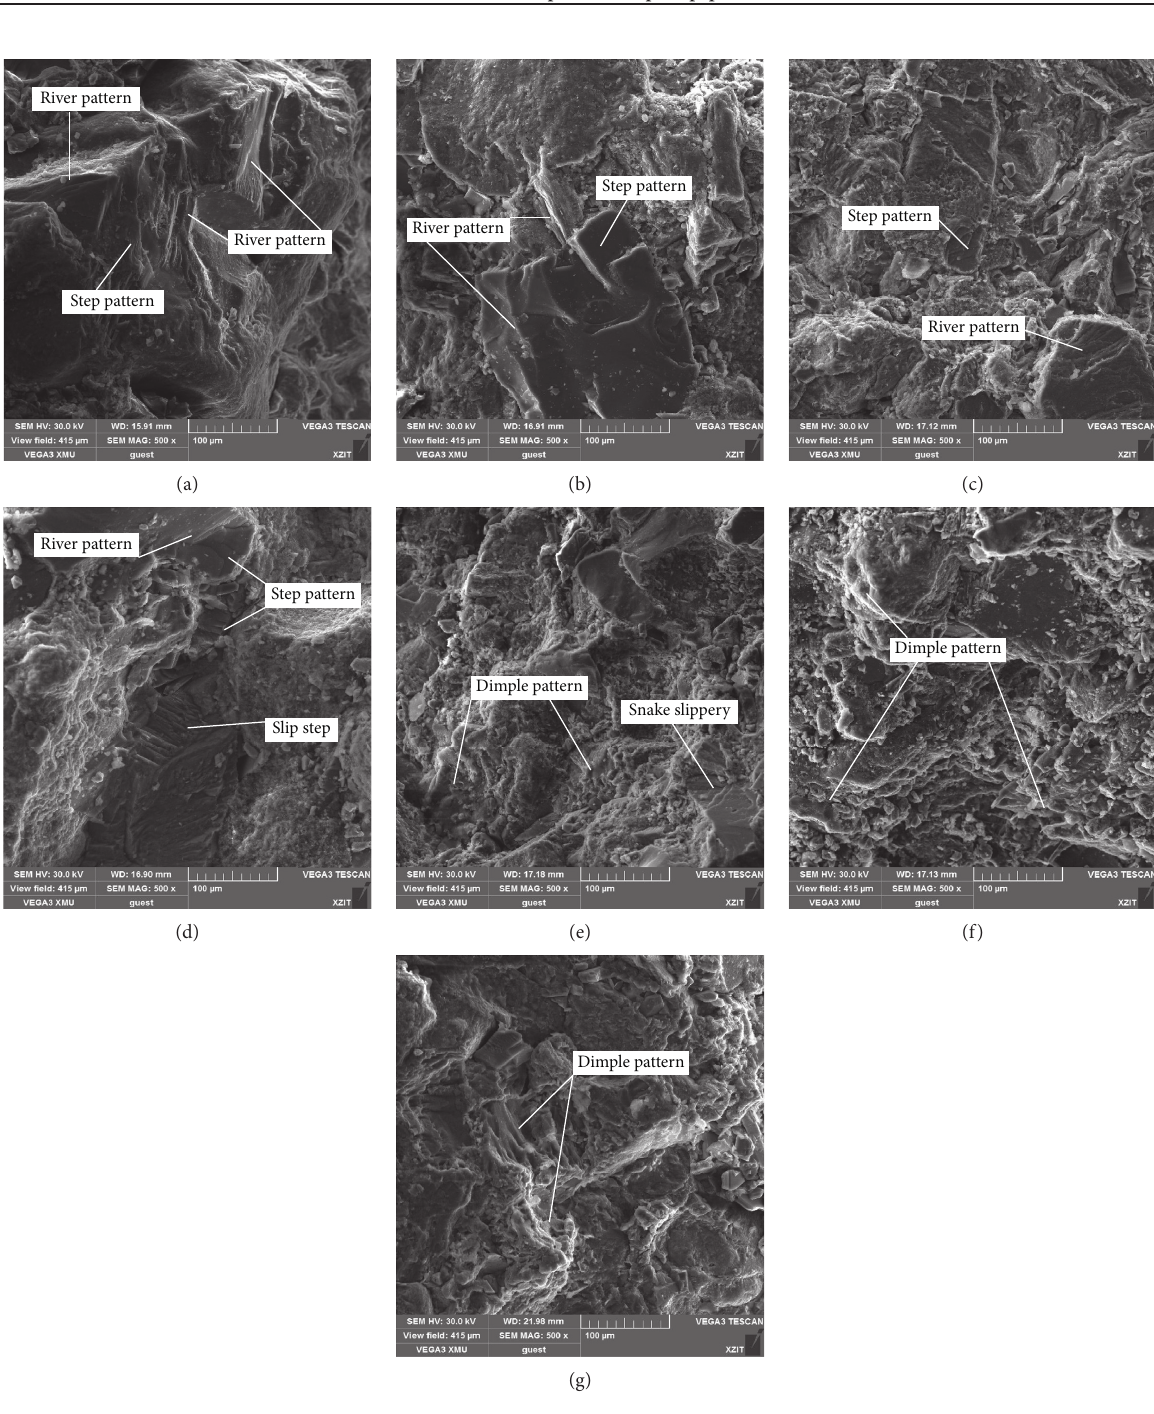
Figure 13: Sandstone fracture morphology with different moisture contents at 500 times magnification: (a) ω � 0%, (b) ω � 2.01%, (c) ω � 2.23%, (d) ω � 2.40%, (e) ω � 2.49%, (f) ω � 2.53%, and (g) ω � 2.58%.